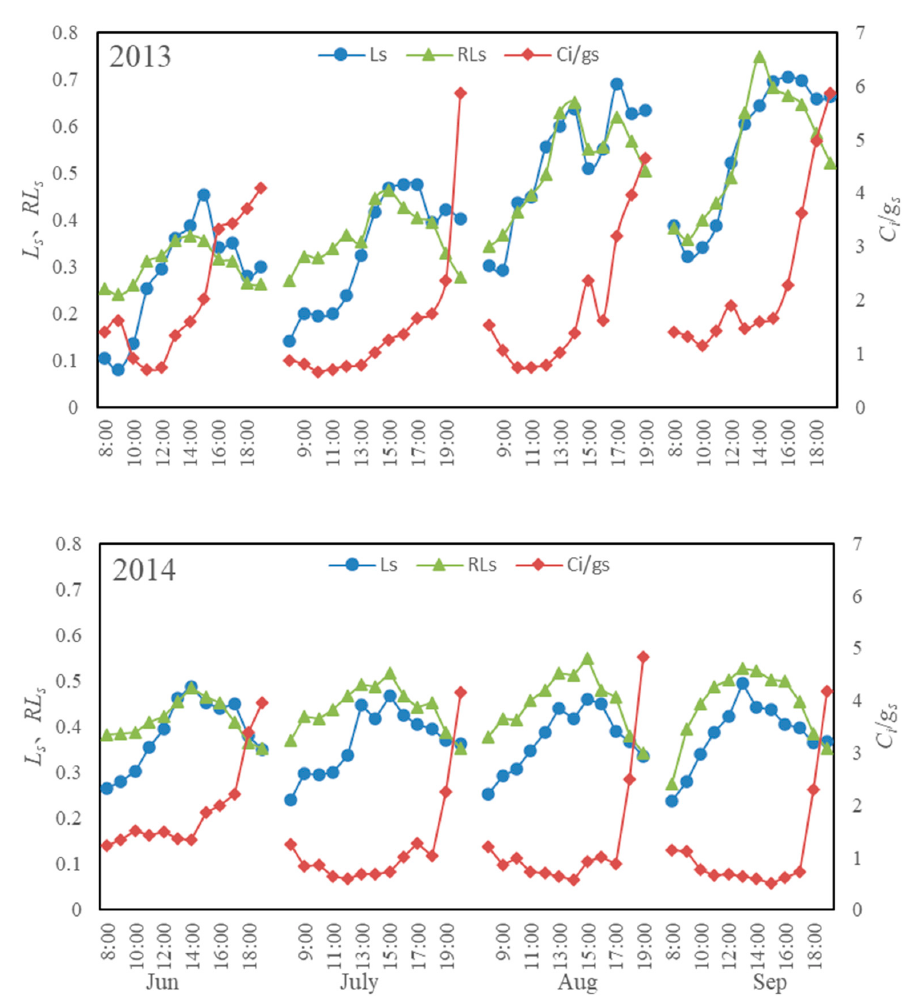
Figure 4 . Diurnal variations in the values of stomatal limitation ( L s ), relative stomatal limitation ( RL s ), and non-stomatal limitation ( Ci/g s ) of photosynthesis of Populus euphratica leaves during the main growing seasons in 2013 and 2014. The values in the figure are averages for each parameter at the same hour on different observational days in each month.